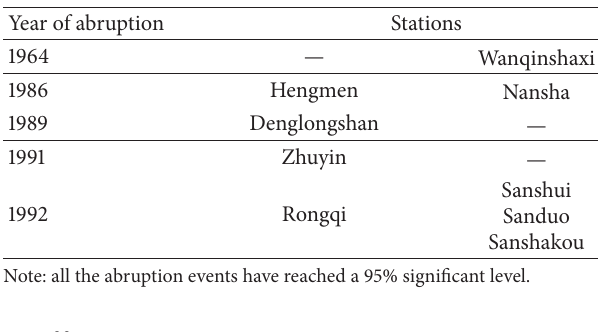
Table 7: Abruption of flood water levels around Pearl River Delta.